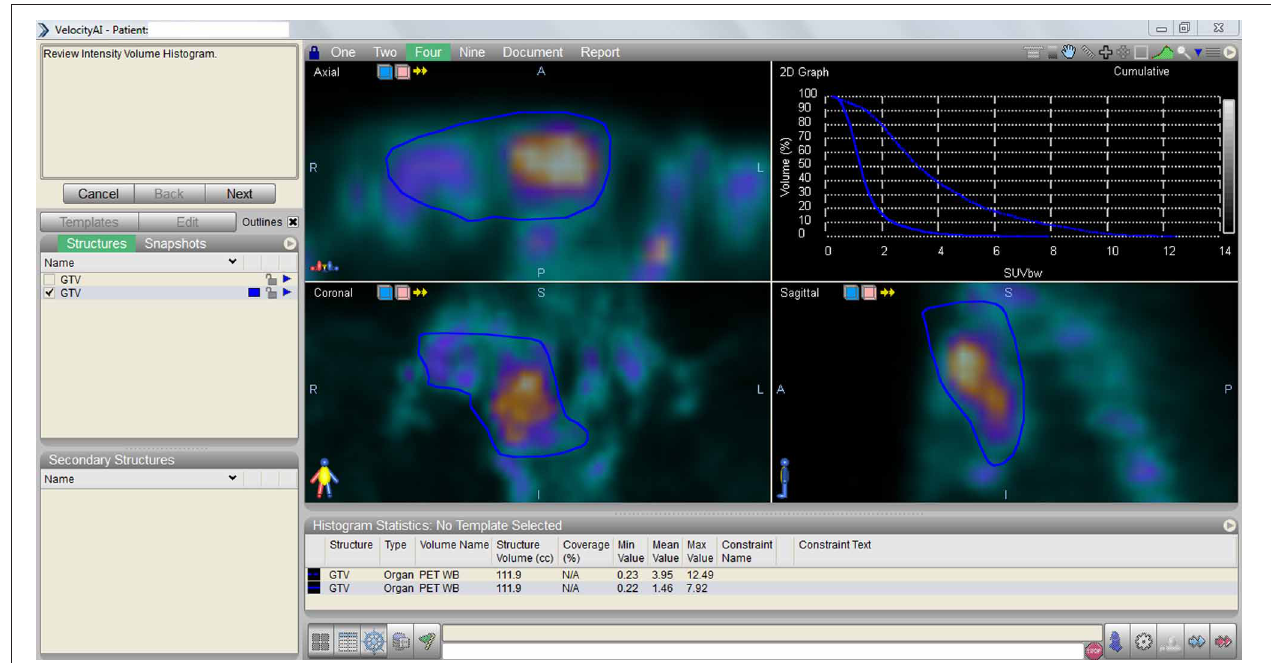
FIGURE 1 | Displayed the assessment graphic containing the data obtained by the comparison of pre-treatment vs. post-treatment PET/CT findings by using Velocity AI “Navigation” tool.